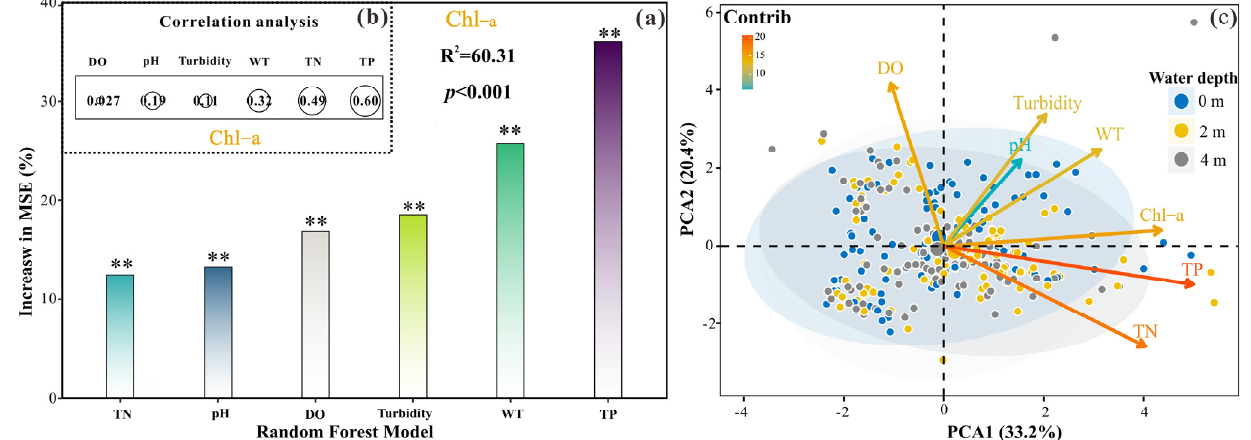
Figure 8. Comprehensive analysis of each water parameter in Lake Qilu. ( a ) Random Forest Model of variables prediction for Chl-a; ( b ) The correlations between Chl-a and each parameter based on correlation analysis; and ( c ) the Principal Component Analysis of all water quality parameters. **: The significance of variables ( p < 0.01).